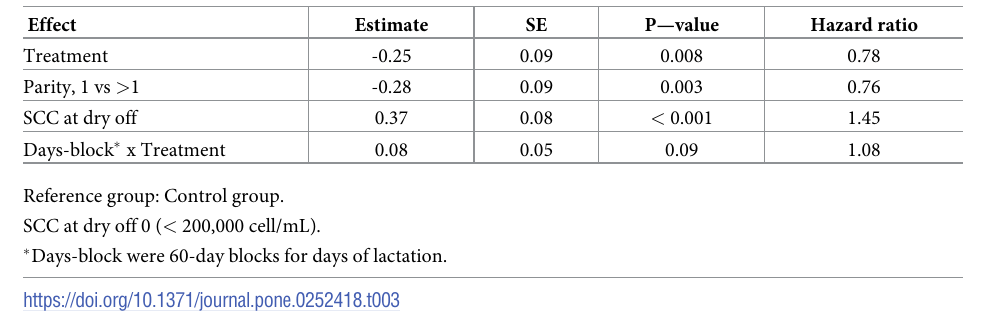
Table 3. Hazard of a first case of CM during a full